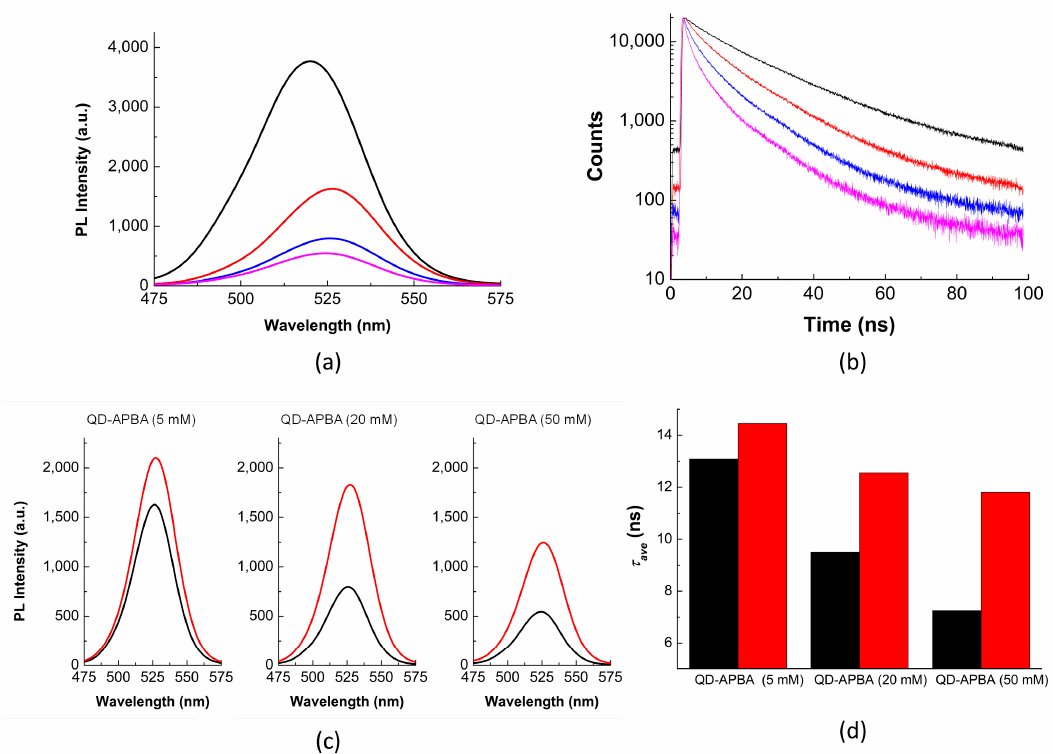
Figure 2. ( a ) Photoluminescence (PL) spectra ( λ ex = 440 nm) and ( b ) PL decay traces ( λ ex = 440 nm and λ em = 520 nm) of QD–MPA (black) and QD–APBA conjugates synthesized with different amounts of APBA during the coupling reaction: 5 mM (red), 20 mM (blue), and 50 mM (magenta). ( c ) PL emission spectra ( λ ex = 440 nm) and ( d ) PL average lifetime of the QD–APBA conjugates synthesized with different amounts of APBA before (black) and after the addition 40 mM glucose (red) (10 mM phosphate buffer, pH 8).